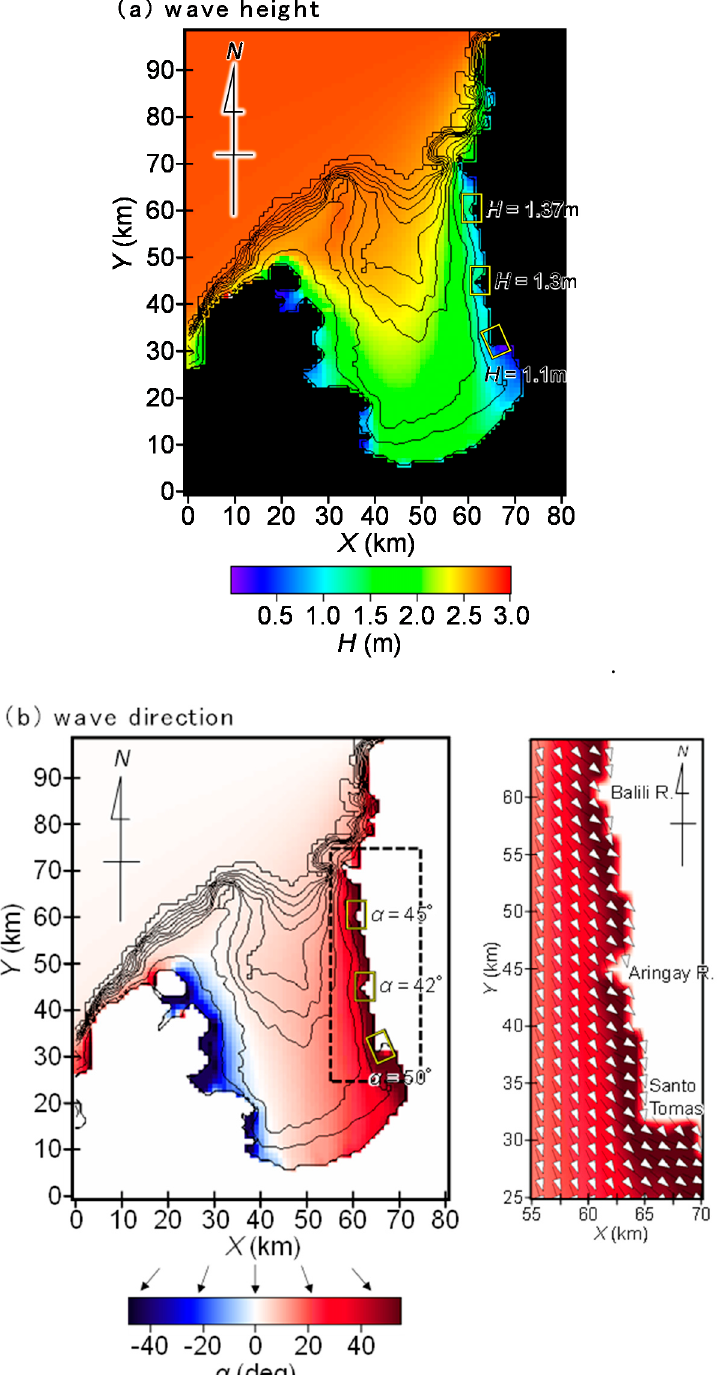
Figure 27. Predicted wave height and wave direction in Lingayen Gulf ( S max = 25) ( a ) wave height, ( b ) waive direction.